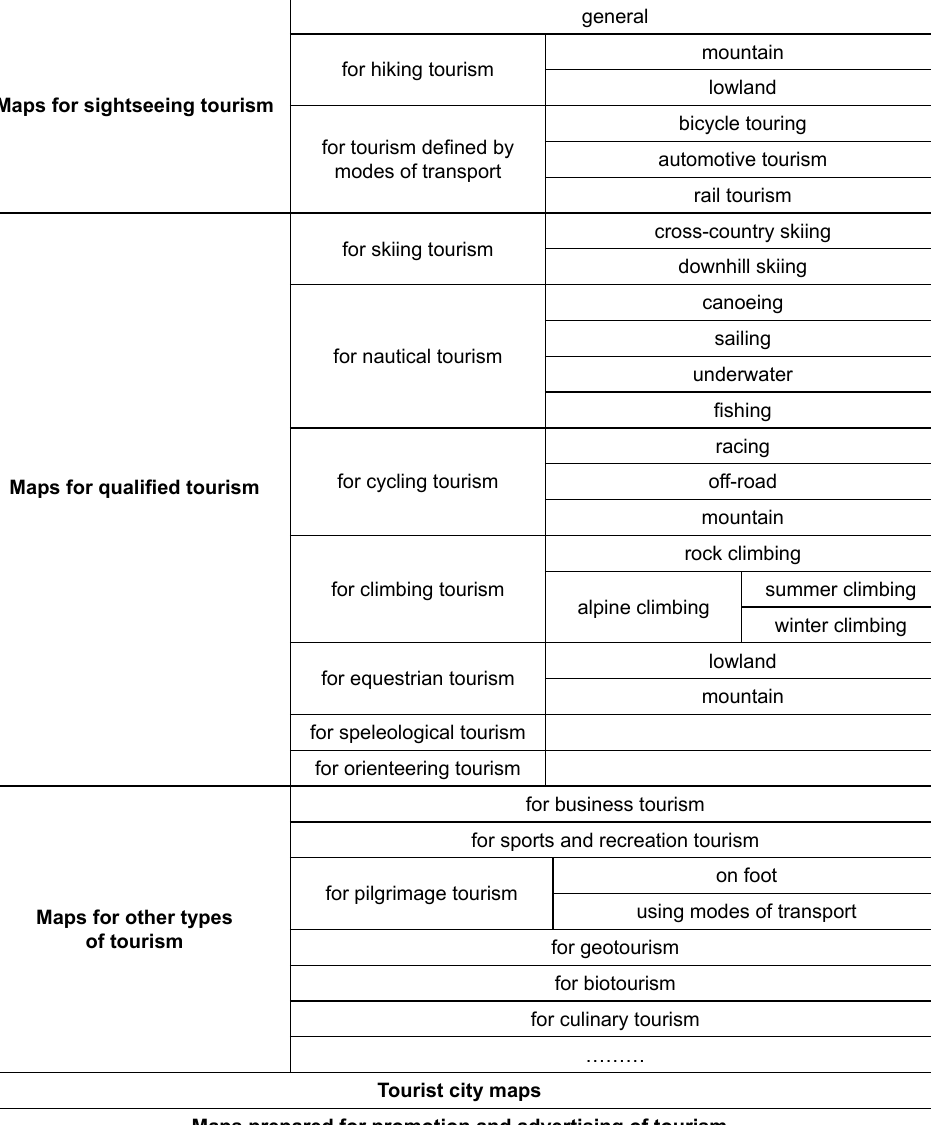
Table 1. Classification of tourist maps in accordance with the aim and type of tourism